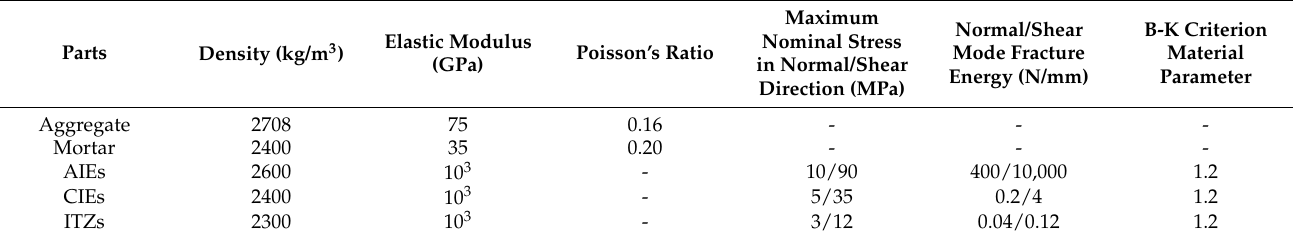
Table 4. Material properties of different